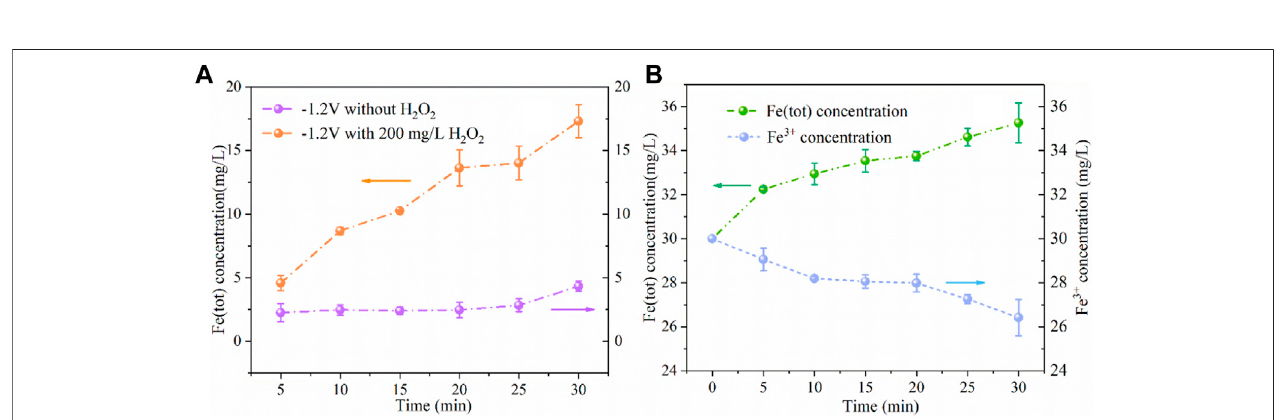
FIGURE 10 | Concentration variations of Fe (tot) and Fe 2+ (A) and Fe (tot) and Fe 3+ (B) under different conditions (PNP (cid:1) 100 mg/L, Na 2 SO 4 (cid:1) 3 g/L, pH 0 (cid:1) 3.0).